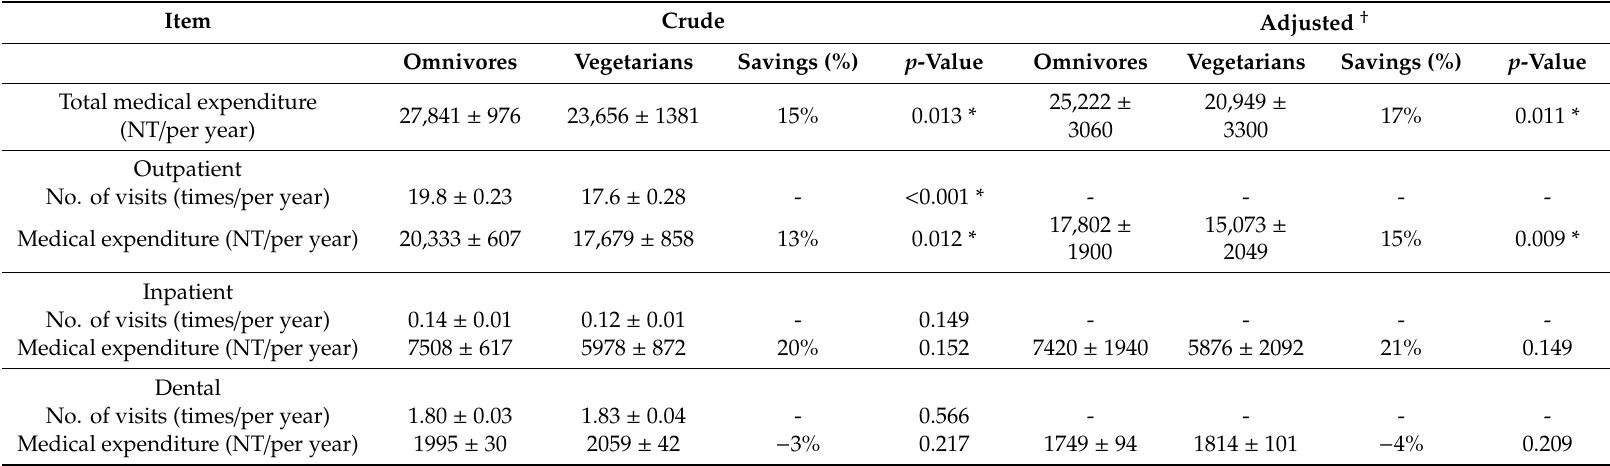
Table 2. Comparison of annual total medical, outpatient, hospitalization, and dental expenditure between omnivores and vegetarians. (N = 6498) in New Taiwan Dollar